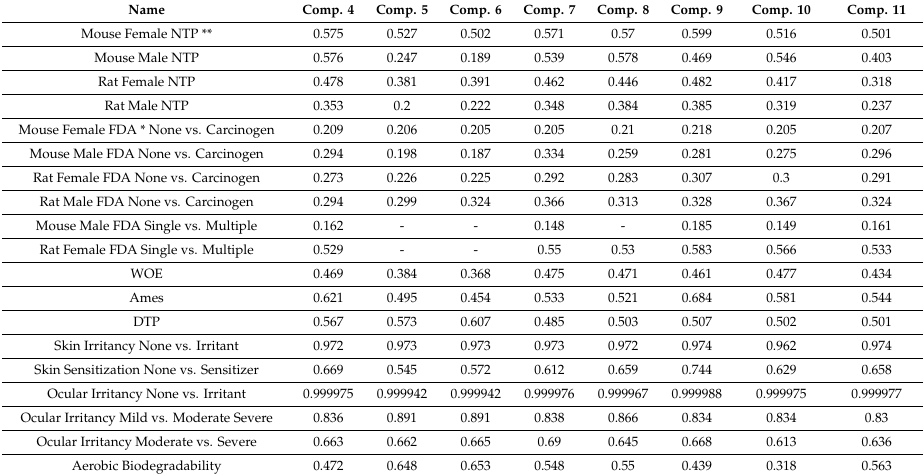
Table 6. Probability values of di ff erent toxicity models of compounds 4 – 11 by TOPKAT